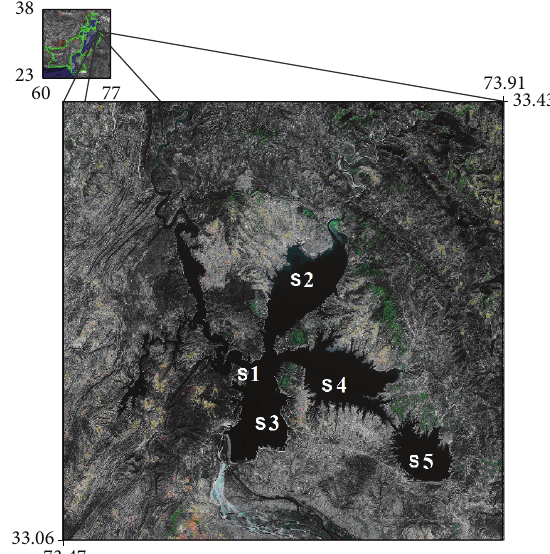
Figure 1: Map of the study area showing sampling sites.